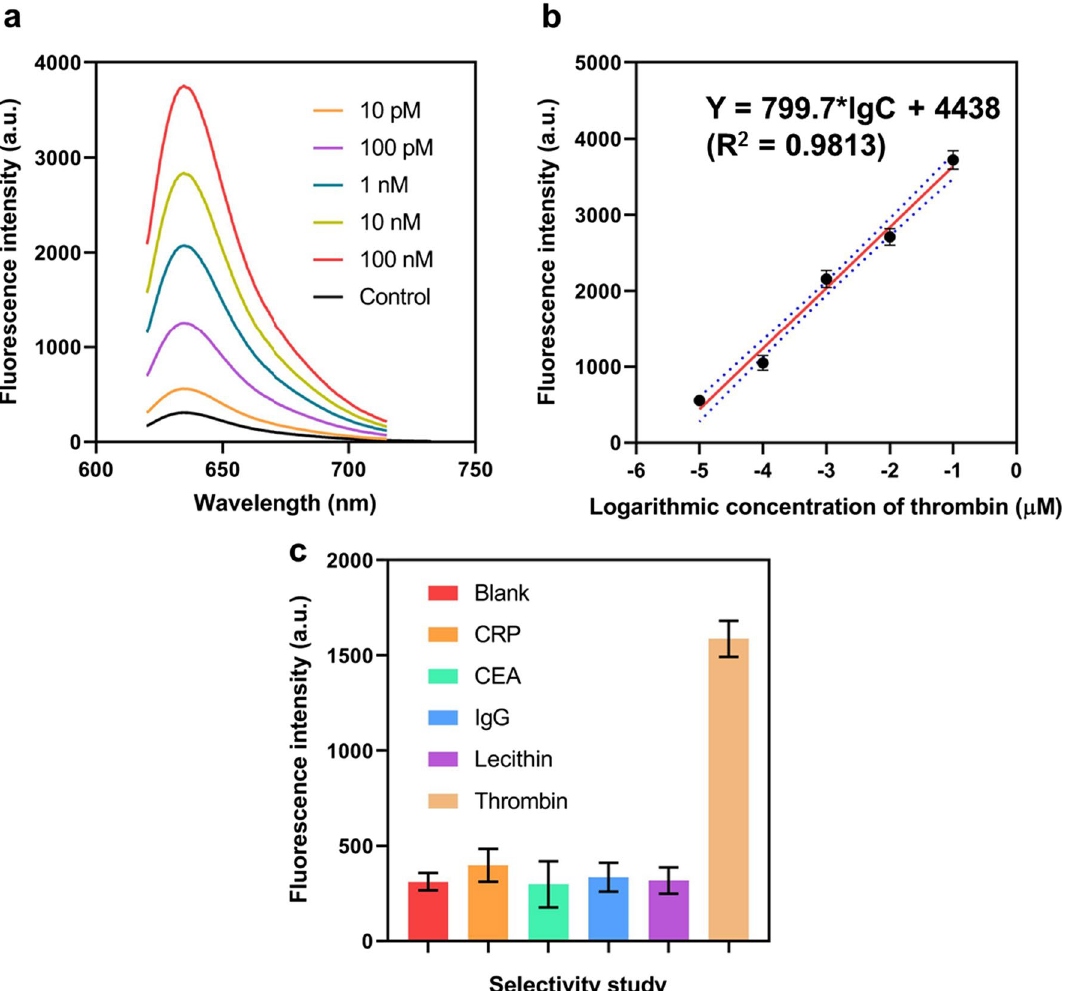
Fig. 4 Analytical performance of the established approach. a Fluorescence spectra of the approach when detecting different concentrations of thrombin. b Linear regression equation between fluorescence intensities and concentration of thrombin. c Fluorescence intensity of the approach when detecting thrombin and other interferents (IgG, CEA, CRP, and